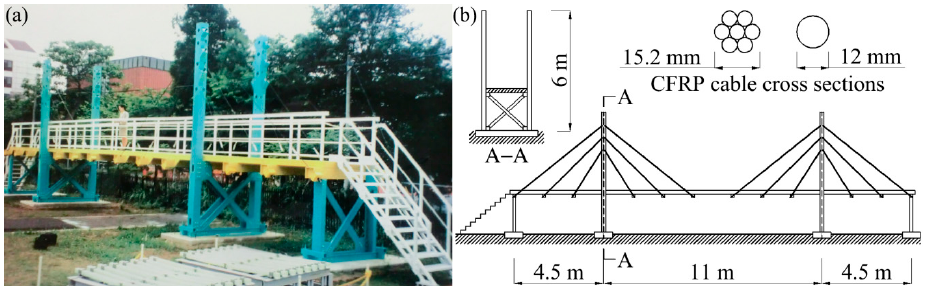
Figure 6. Tsukuba FRP Bridge, ( a ) photo (photo credit: Iwao Sasaki) and ( b ) sketch.